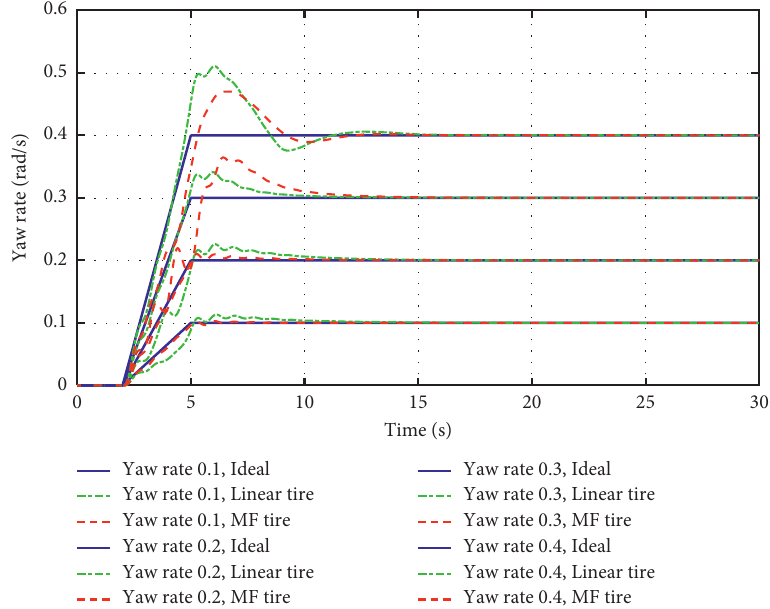
Figure 7: Comparison of yaw rate with different tire models.